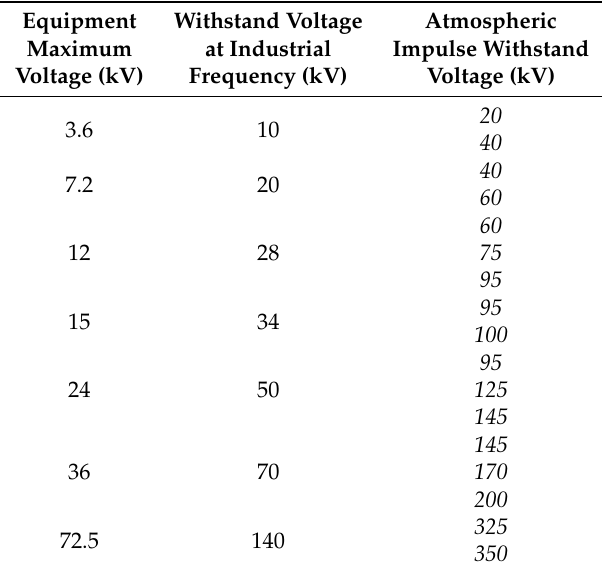
Table 2. Normalized insulation levels up to 72.5 kV.